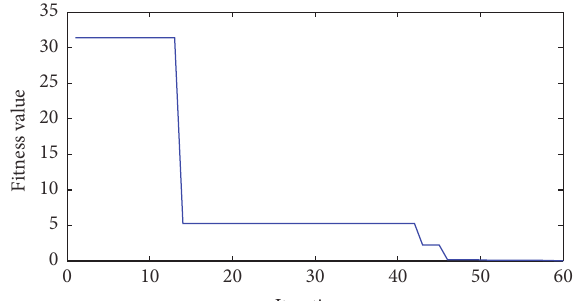
Figure 9: Improved PSO iterative process and the optimum fitness value.